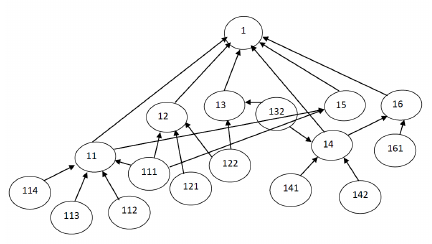
Fig. 2: Graphical Bayesian model for predicting the ro- tor